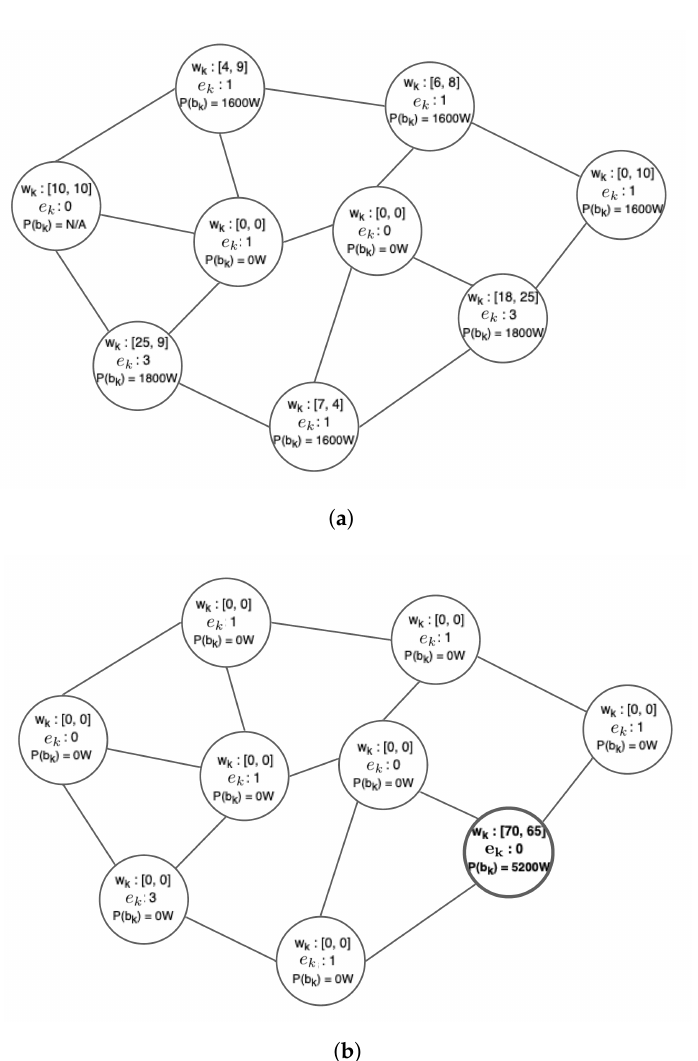
Figure 5. Workload redistribution example: starting and final states. ( a ) starting state; ( b ) final